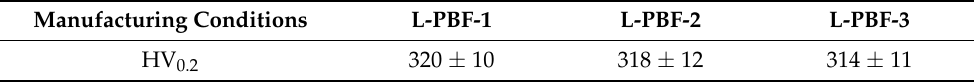
Table 3. Vickers microhardness values of the three L-PBF samples.